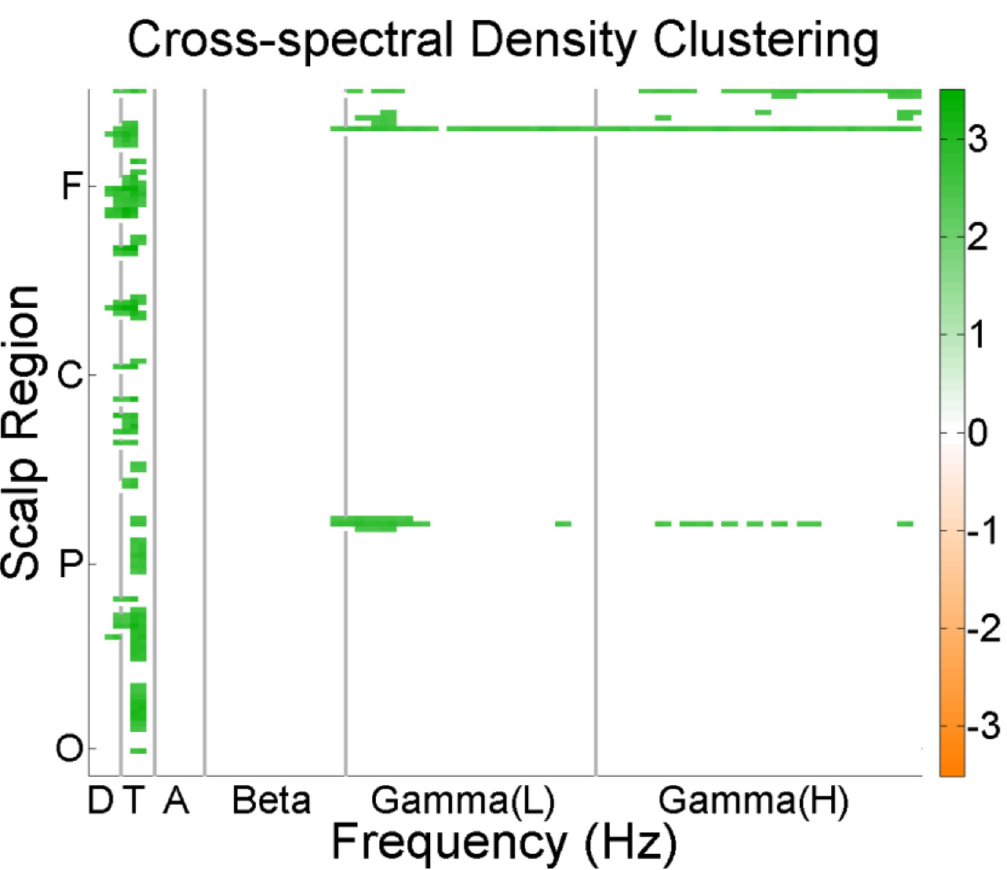
Fig 2. Scalp network connectivity. Shows difference in clustering coefficients between patients (green) and controls (orange) in different scalp regions. (F = Frontal, C = Central, P = Parietal O = Occipital) (D = Delta, T = Theta, A = Alpha L = Low, H =